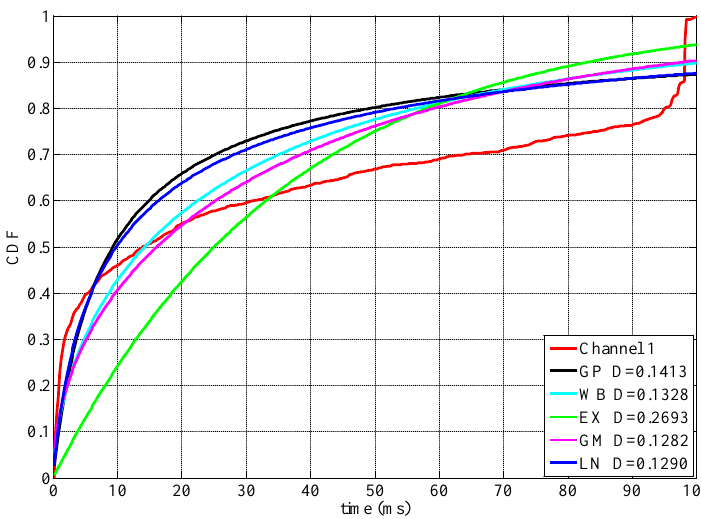
Figure 6. Empirical CDF versus fitted distribution of channel ‘1’.